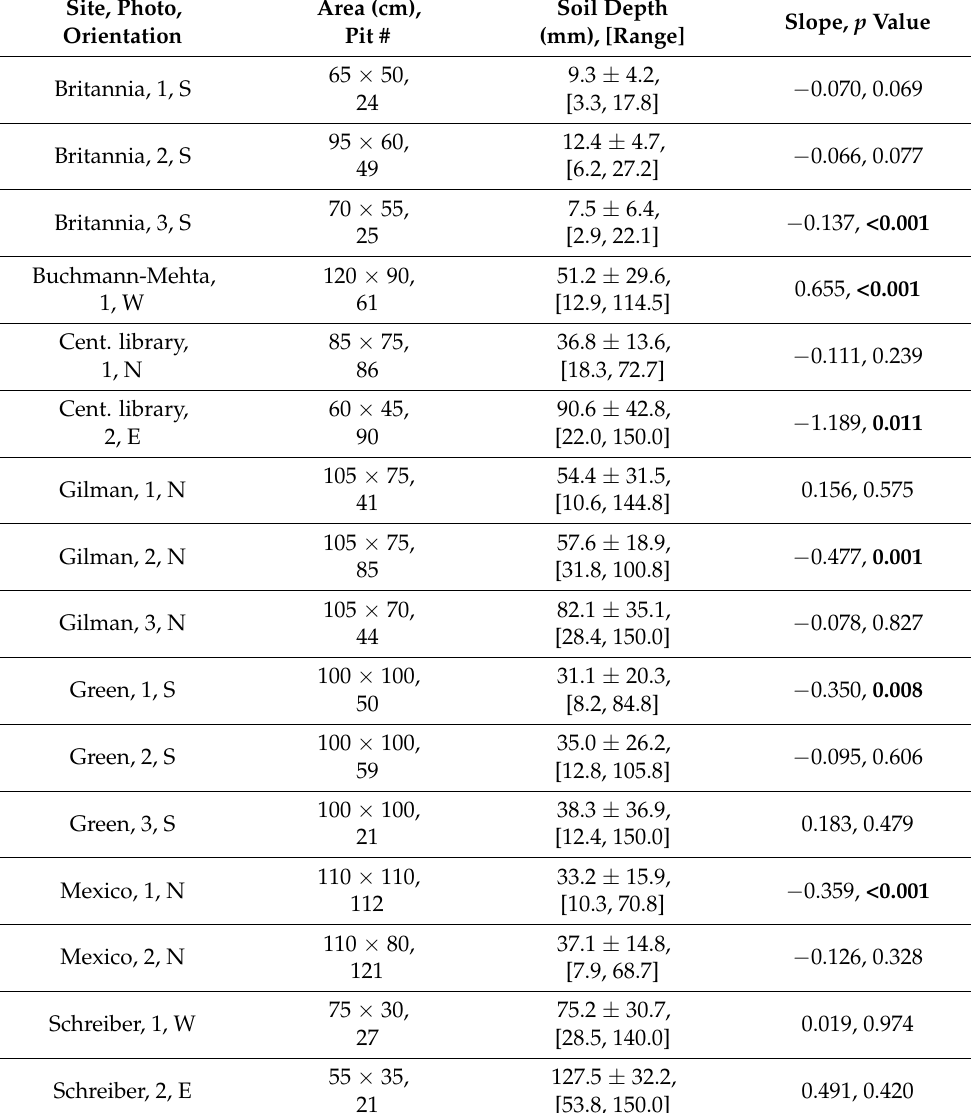
Table 1. The site names, photo numbers, orientation, wormlion zone area, number of pits, soil depth (mean ± 1 SD, range), and the slope (and p value) of soil depth vs. the distance from the wall, per photo per